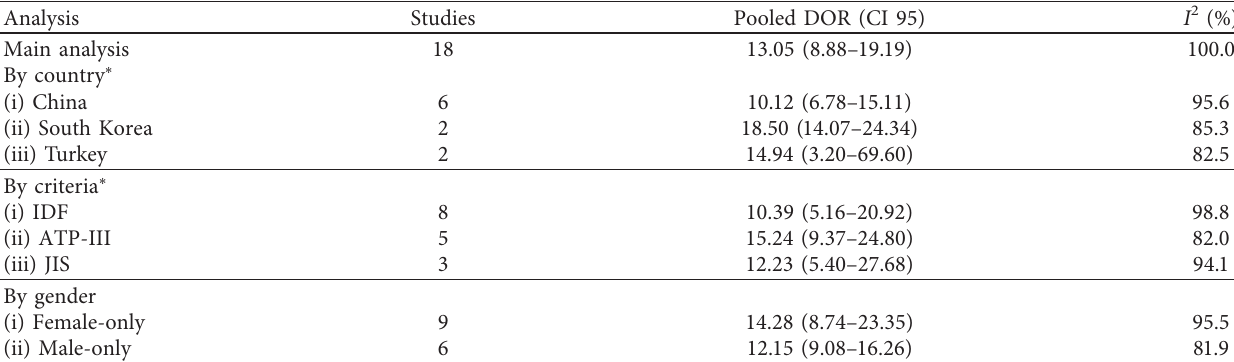
Table 2: Main meta-analysis and subgroup analyses of diagnostic odds ratio.